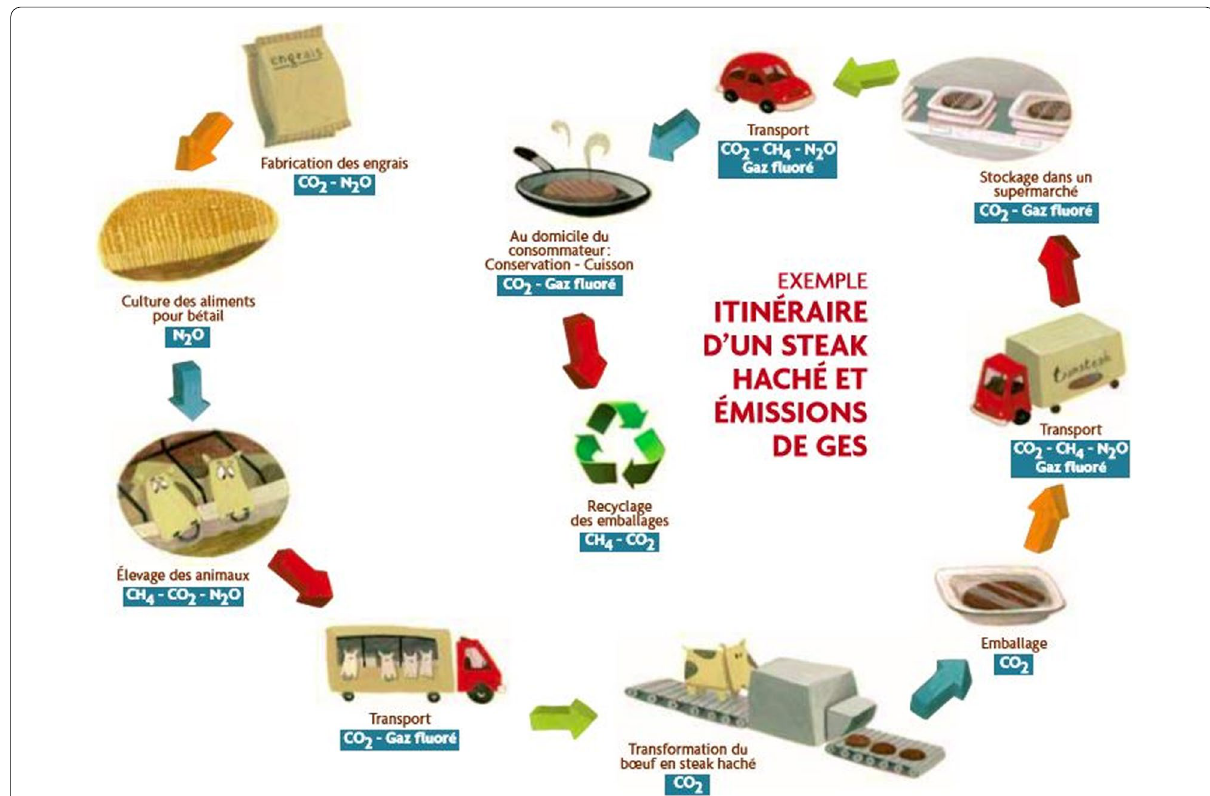
Fig. 1 Representative slide from a student presentation about Consumption and climate change. Credit: extrait d’une brochure “Des gaz à effet de serre dans mon assiette” publiée par Réseau action climat France (itinéraire d’un steak haché et émissions de GES) . (The publisher gives permission to use these in public education.)